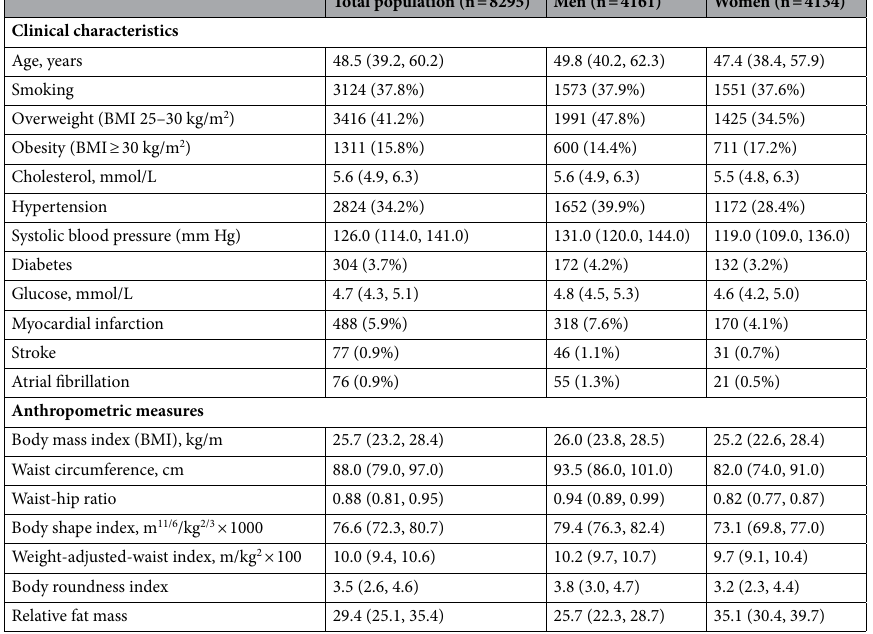
Table 1. Baseline characteristics of PREVEND participants. Continuous variables are presented as medians (25th–75th percentile) and categorical variables as n